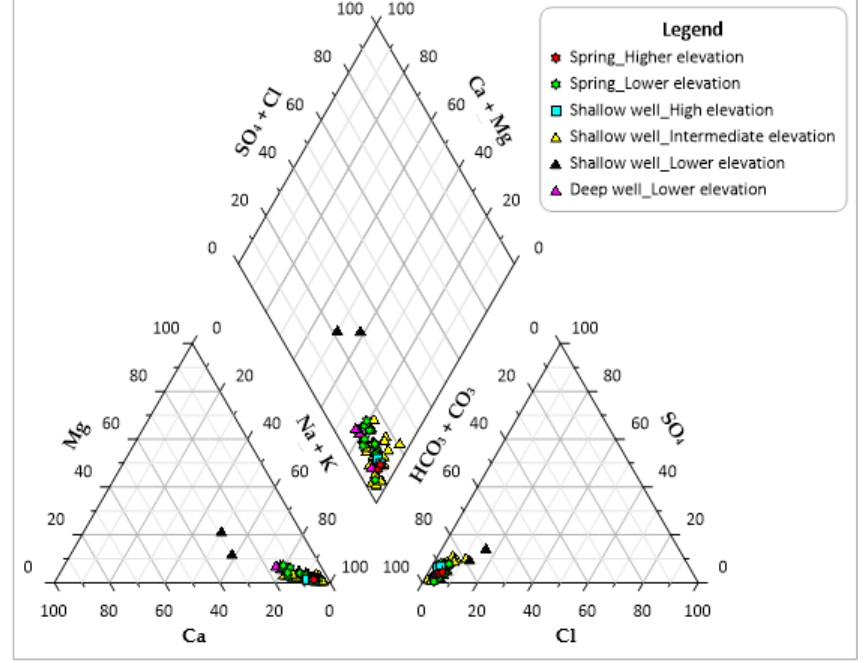
Figure 12. Piper diagram showing different water samples taken from springs, shallow wells, and deep wells on the southwestern flank.